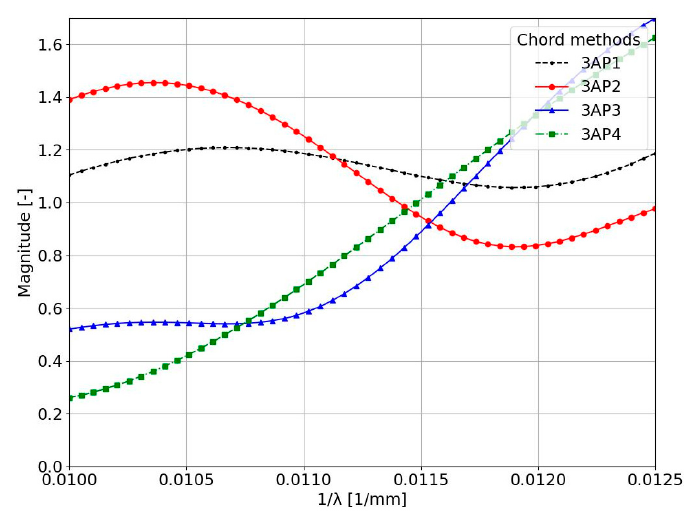
Figure 4. The transfer function for the different chord methods in the wavelength range between 80 mm and 100 mm .